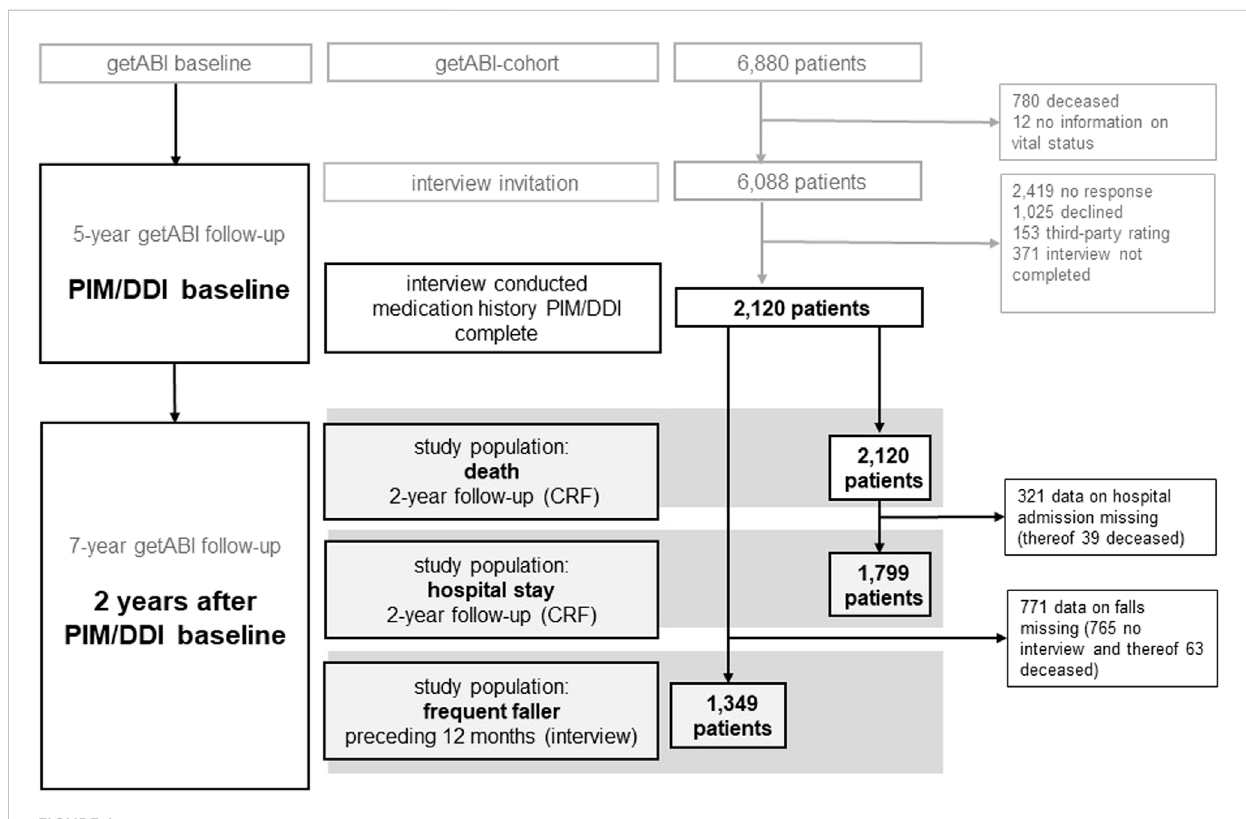
FIGURE 1 Flow chart outline of the inclusion of participants in the